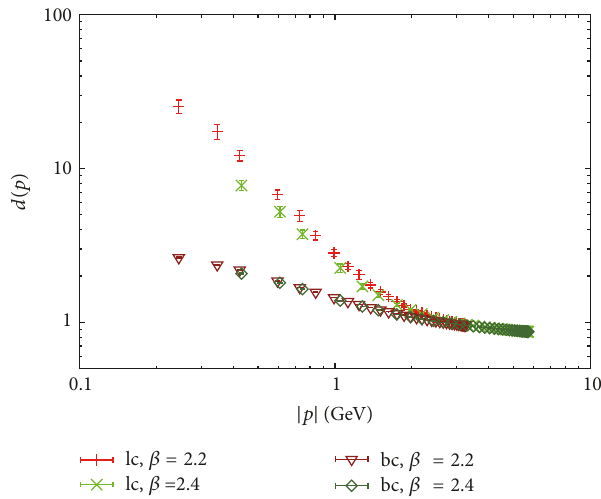
Figure 9: The ghost form factor after 10000 copies of bc and lc